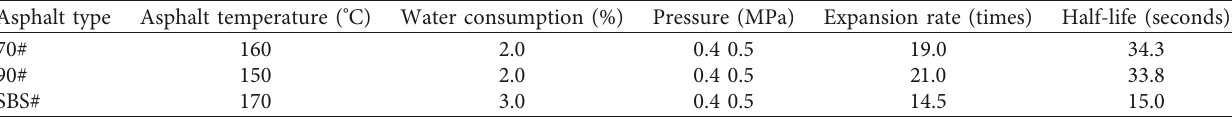
Table 1: Technical indexes of foamed asphalt for test.